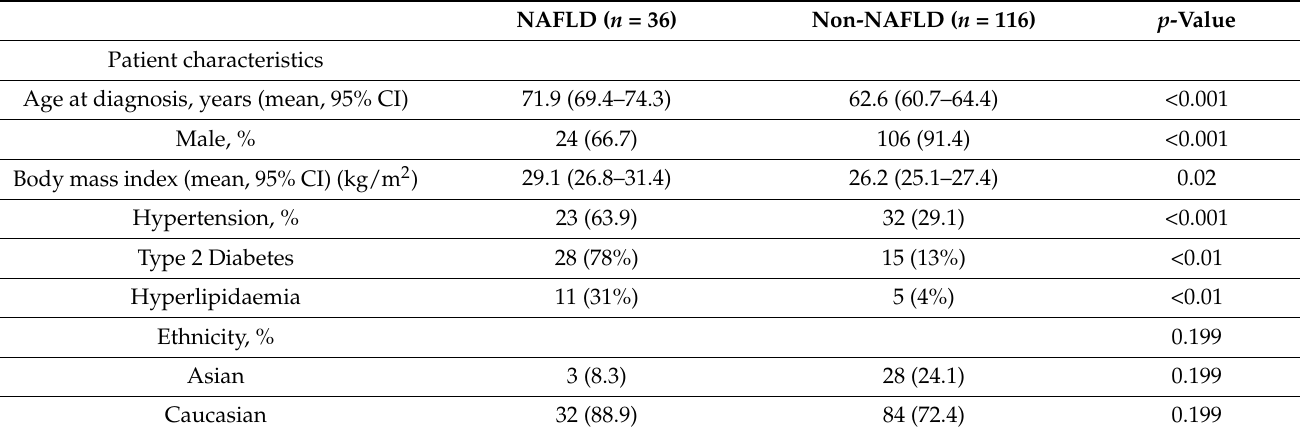
Figure 1. Flow chart of patients included in the analysis and grouping of patients. HCC: Hepatocel- lular carcinoma; NAFLD: Non-alcoholic fatty liver disease. Table 1. Baseline Characteristics of Patients with NAFLD-HCC and